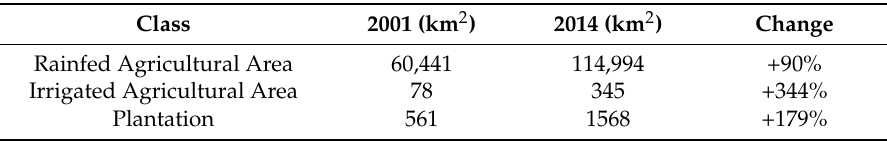
Table 3. Agricultural area in km 2 and percentage change for the years 2001 and 2014.